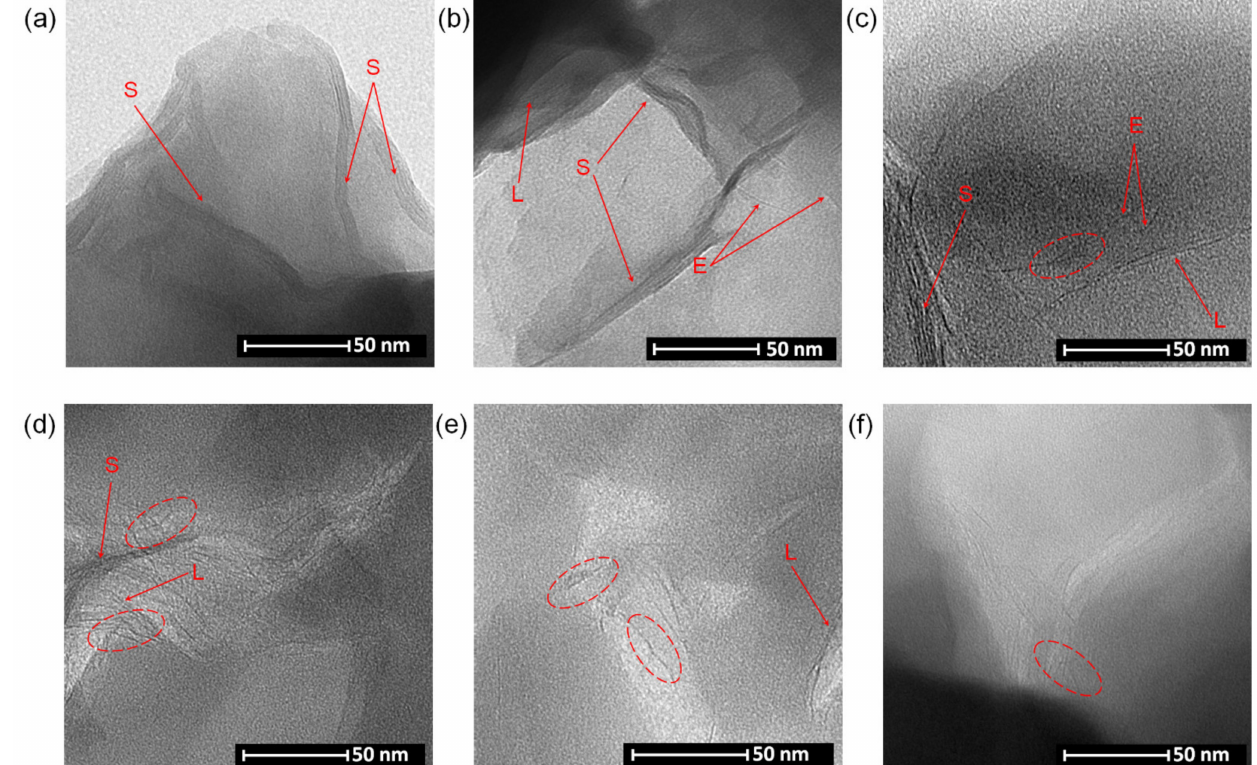
Figure 8. TEM images of organo-montmorillonite dispersed within a polysiloxane matrix: ( a ) PAMtC 12 , ( b ) PBMtC 16 , ( c ) PAMtBC 14 , ( d ) PBMtBC 14 , ( e ) PAMtBC 16 , and ( f ) PBMtBC 16 . (The house of cards structures and clay mineral layers (S-stacks of a few clay mineral layers, E-single exfoliated layer, L-stacks of two to three clay mineral layers) are marked with red ovals and arrows,